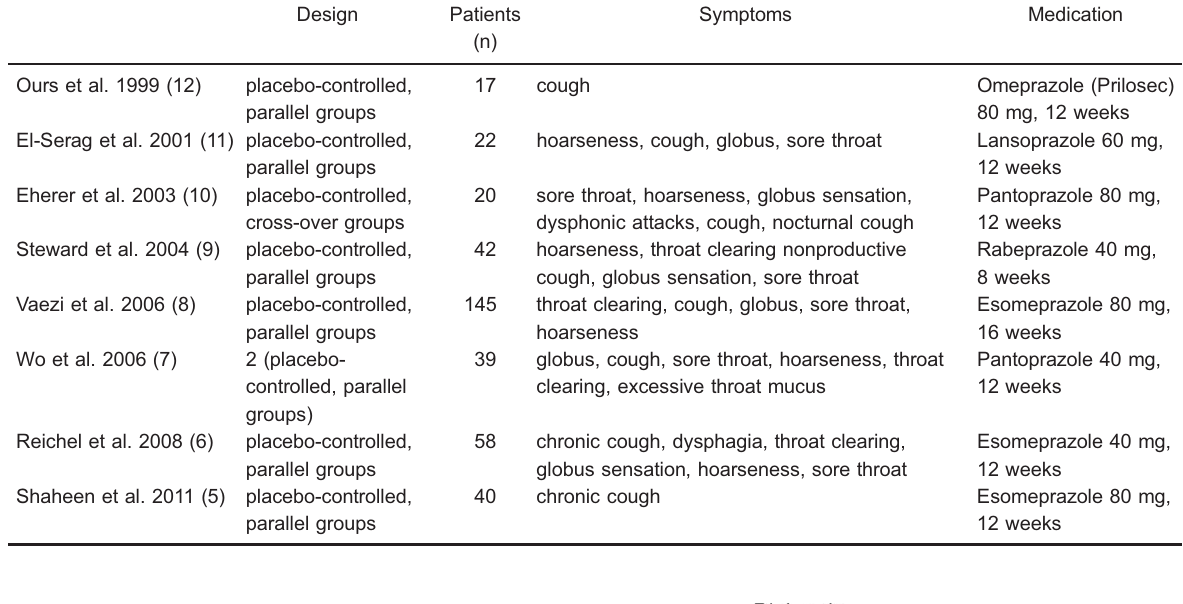
Table 1. Characteristics of the studies included in the meta-analysis.